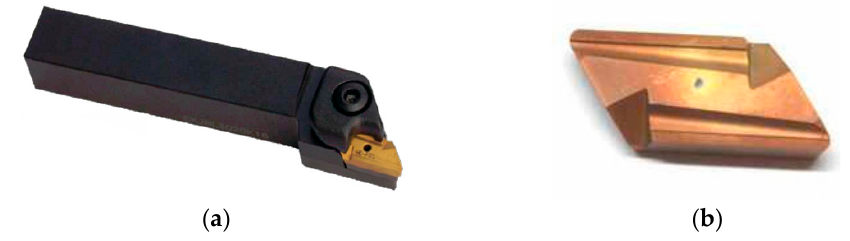
Table 4. Chemical compositions (in weight %) of material of the machined workpiece (according to the manufacturer’s specifications; SIJ Metal Ravne, Slovenia).